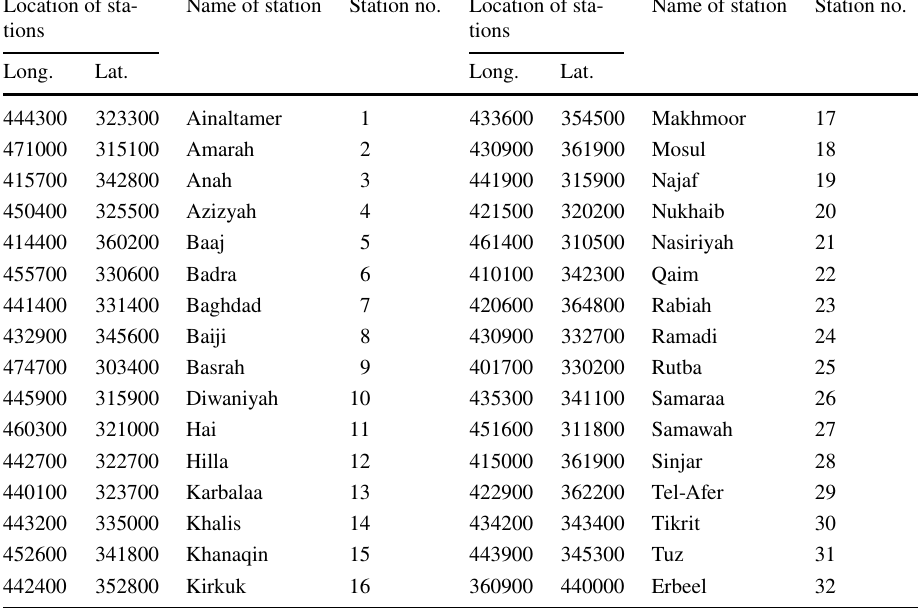
Location of sta-